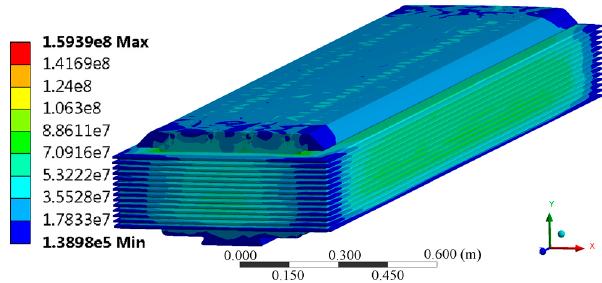
Figure 13. Thermal stress distribution of magnetic pole under normal conditions.